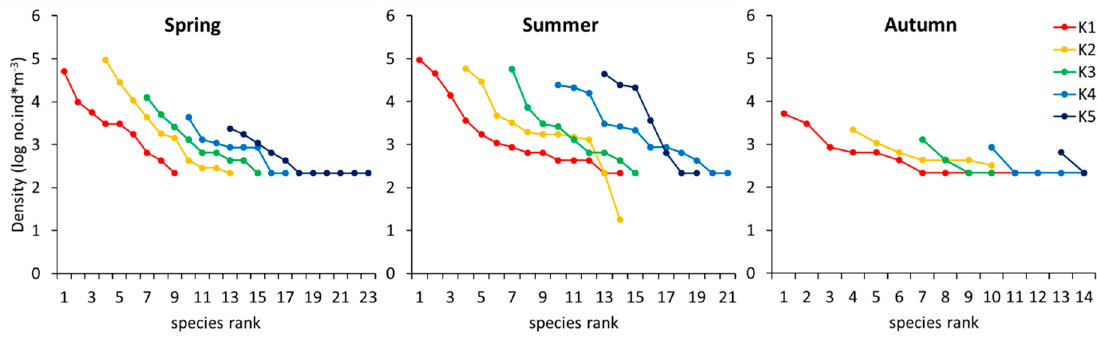
Figure 2. Rank-abundance curves of the seasonal rotifer assemblages at different distances (K1–K5) from the inflow point. (To decrease overlap, the starting positions of the individual curves were displaced by three positions).